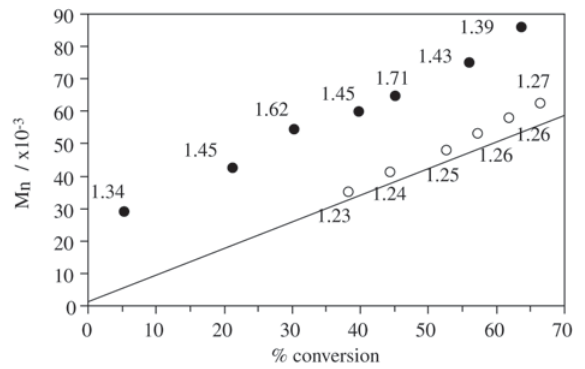
Figure 1. Comparison between the molecular weights of PMMA hybrids initiated by OCPS (filled) or OBPS (open) under similar reaction conditions. Line represents the theoretical M studies and numbers are PDI values according to GPC. [initia- tor] = 2.92 mM, [CuCl] = 23.4 mM, MMA:initiator group (–Cl or –Br) =